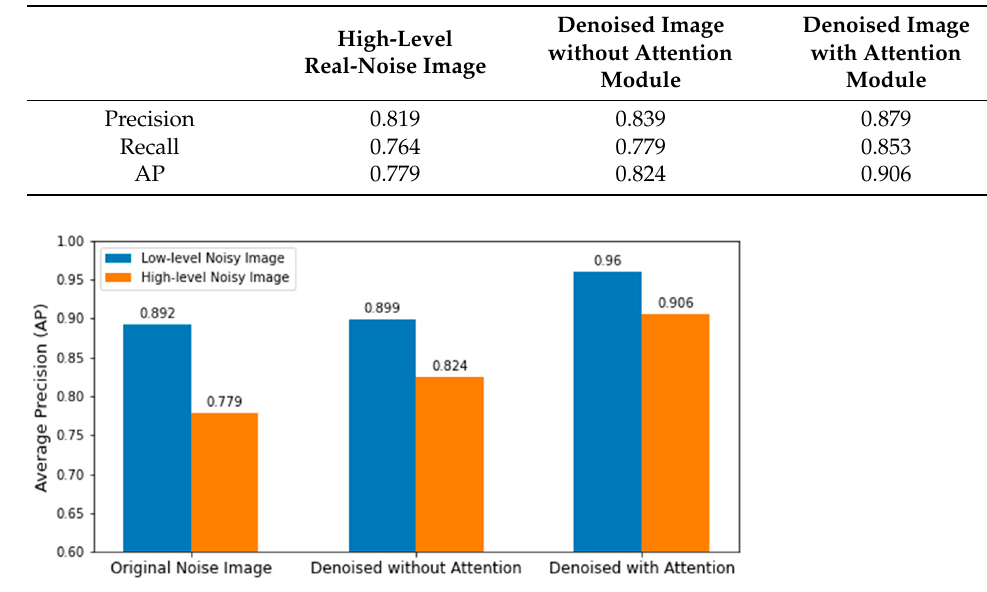
( d ) Figure 10. Denoised image produced by the model with and without the attention module on the simulated noisy image: ( a ) simulated noisy image; ( b ) denoised image without attention module; ( c ) denoised image with attention module; ( d ) Clean image.